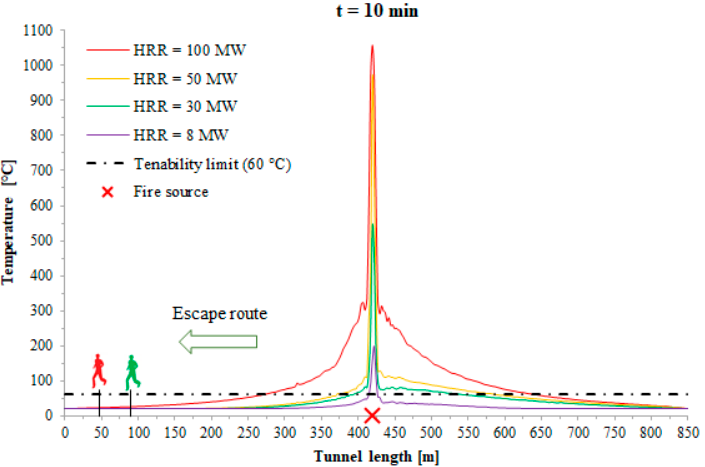
Figure 3. Longitudinal temperature profiles (t = 10 min) at a height of 2 m along the escape path when the fire source is in the middle of the tunnel